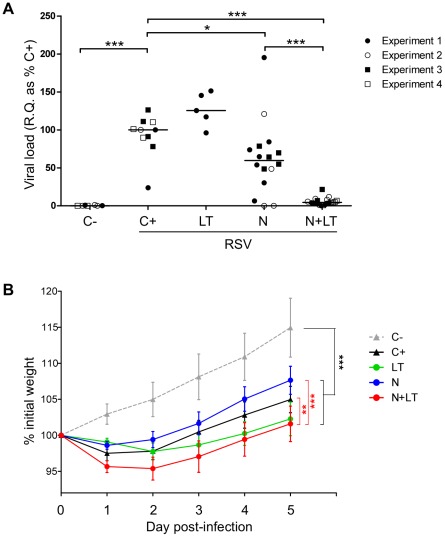
Neonatal nasal vaccination with N+LT conferred viral protection but exacerbated airway disease upon RSV challenge.Male and female pups (5–7 day-old) were vaccinated by intranasal instillation of 10 µL saline containing or not 3 µg N and 2 µg LT as indicated. At 5 weeks of age, mice were challenged by intranasal instillation of 50 µL (5.106 pfu) hRSV A2. Controls included unvaccinated infected (C+) and uninfected (C−) littermates. Animals were killed 5 days post challenge (d5 p.i.). (A) Individual viral load assessed by qRT-PCR: R.Q. of N transcripts, normalized to HPRT, are expressed as % of the unvaccinated infected control group (C+) (R.Q. = 100×2−ΔΔCt). Four independent experiments combining different treatment groups are shown with ≥5 mice per group (C−: n = 7, C+: n = 10, LT: n = 5, N: n = 16, N+LT: n = 20). Mann-Whitney U-test was used for comparison between treatments (* p<0.05; *** p<0.001 and **** p<0.0001). (B) Mice were weighed daily from d0 till d5 p.i. and individual weight loss/gain was calculated as % of initial weight. Data are mean±SEM from n≥5 mice per group. Statistical analysis was performed to compare growth over the period d2 to 5 p.i. using the Tukey's multiple comparison test, repeated measures one way ANOVA (** p<0.01 and *** p<0.001).